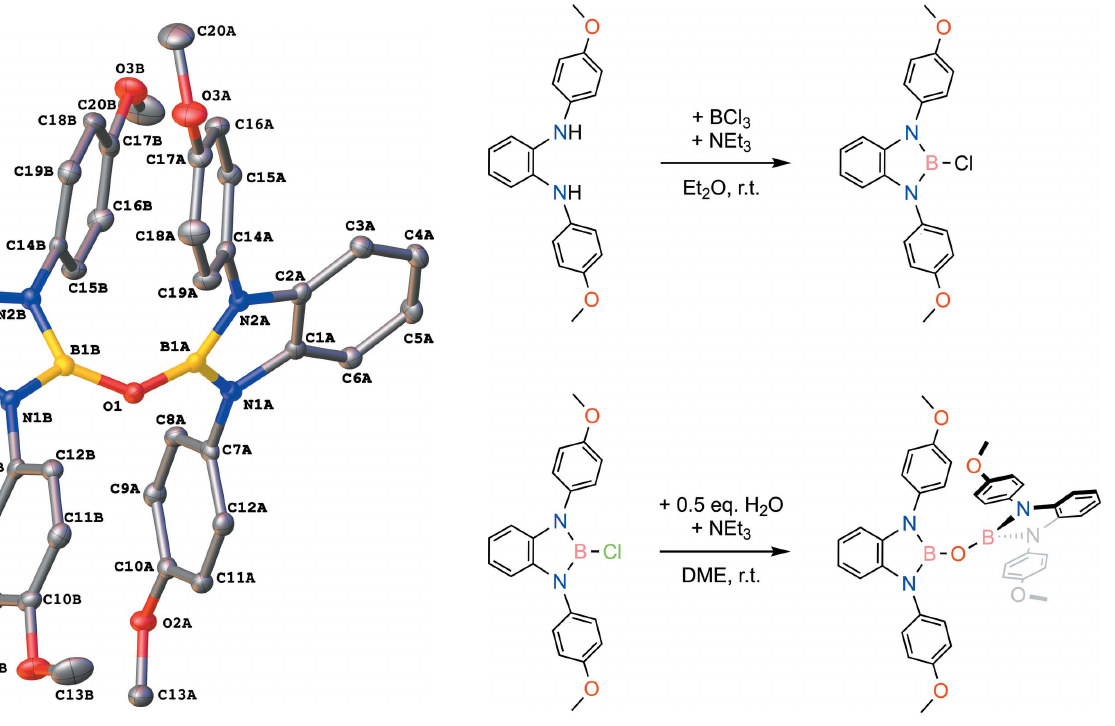
Figure 2 Chemical scheme for the synthesis of the title compound.